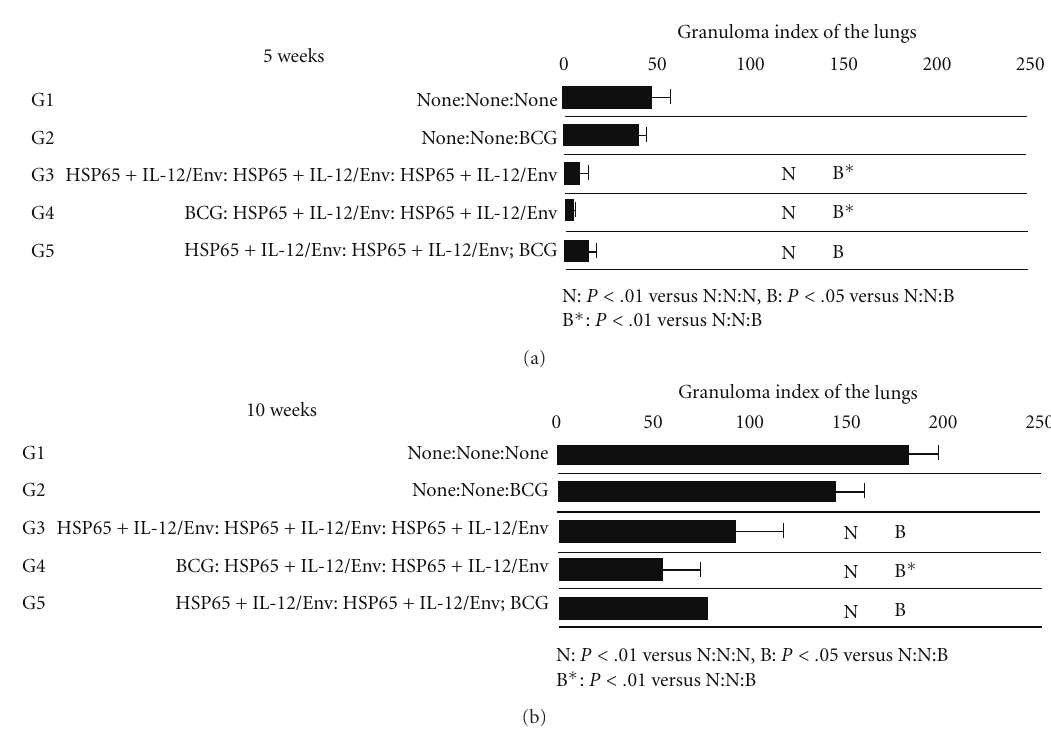
Figure 7: Granuloma index of the G1, G2, G3, G4, and G5 (DNA/DNA/BCG) groups in the lungs 5 weeks and 10 weeks after M. tuberculosis challenge. Results are expressed as the mean ± S.D. of triplicates of 5 mice per group. The statistical significance of di ff erences between the groups was determined by Dunnett test, P < . 01 as compared with the naive (N) group or the BCG alone (B) group. P < . 05 as compared with the BCG alone (B ∗ ) group. The statistical significance of di ff erences ( P < . 05) of granuloma index of 5 weeks G3 group compared to the G4